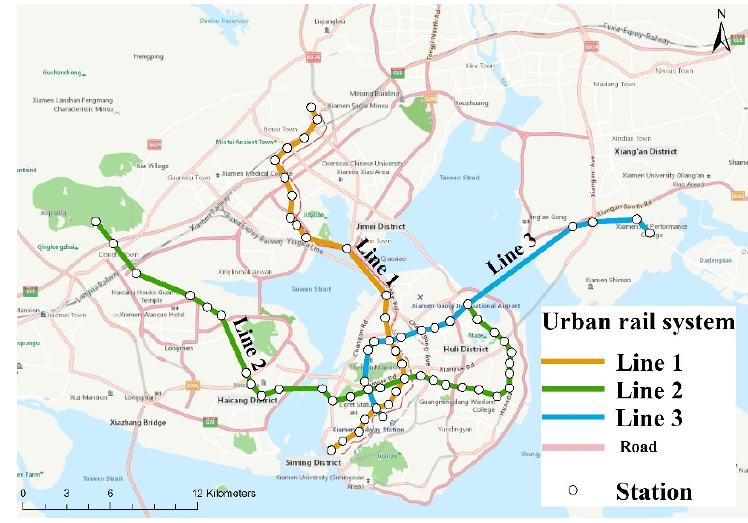
Figure 2. Urban rail system in Xiamen Island (main).